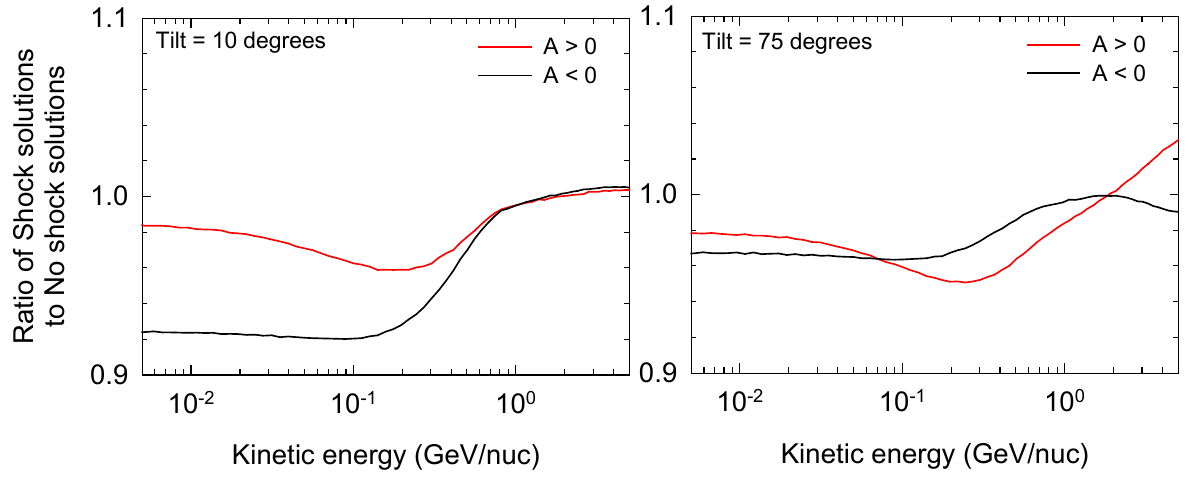
Fig. 4. Computed intensity ratios, B/C, with a TS in the model compared to those without a TS as a function of kinetic energy at Earth for both polarity cycles with α = 10 ° and 75 ° , respectively.